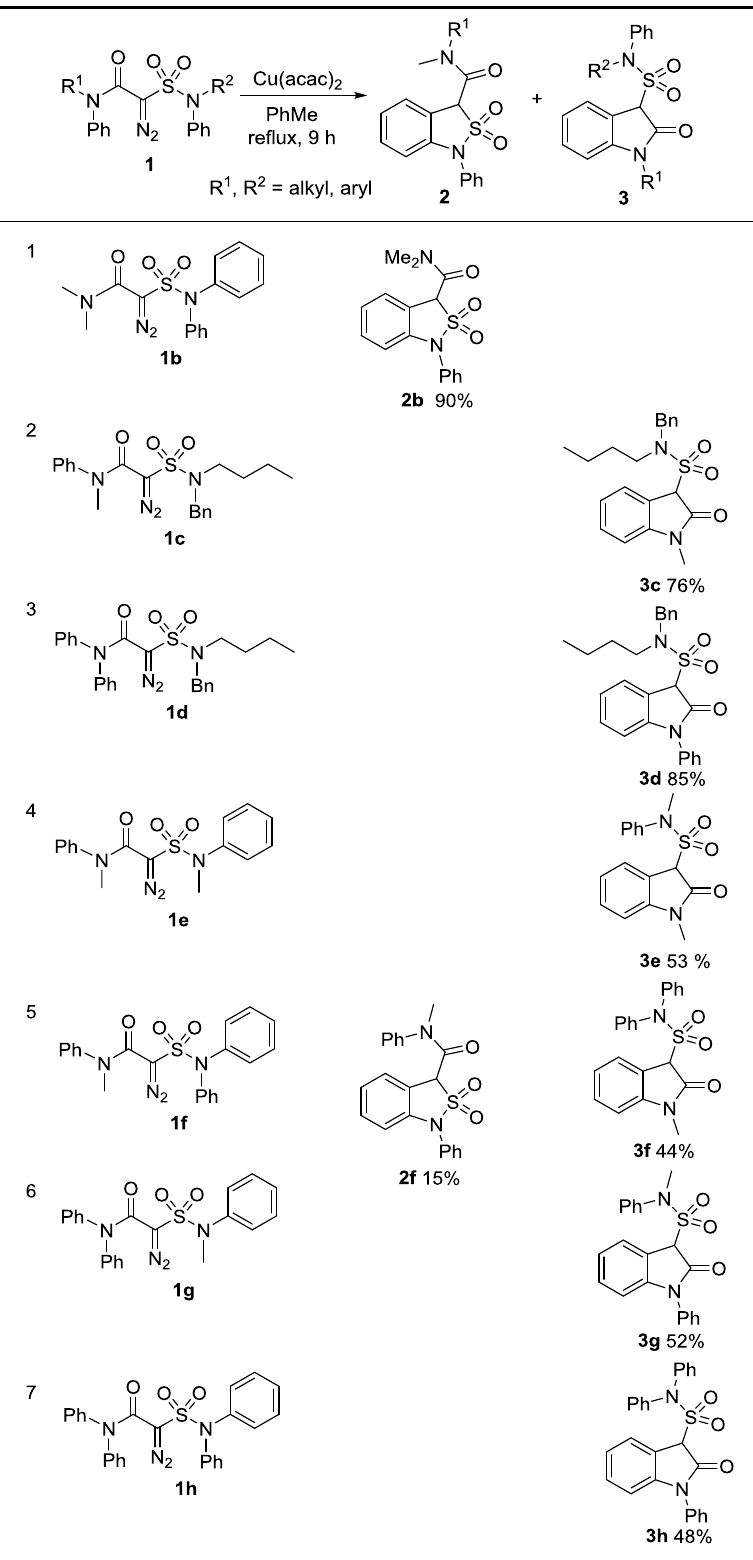
Molecules 2017 , 22 , x FOR PEER Table 2. Intramolecular carbene C-H insertions of diazosulfamoylacetamides 1 a .